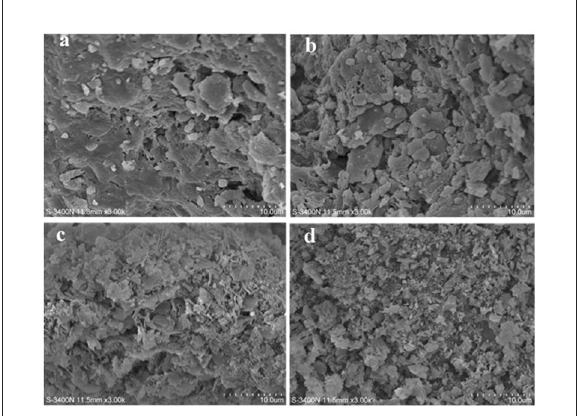
FIGURE3 The thermodynamic characteristics of SDF obtained from different extraction methods.